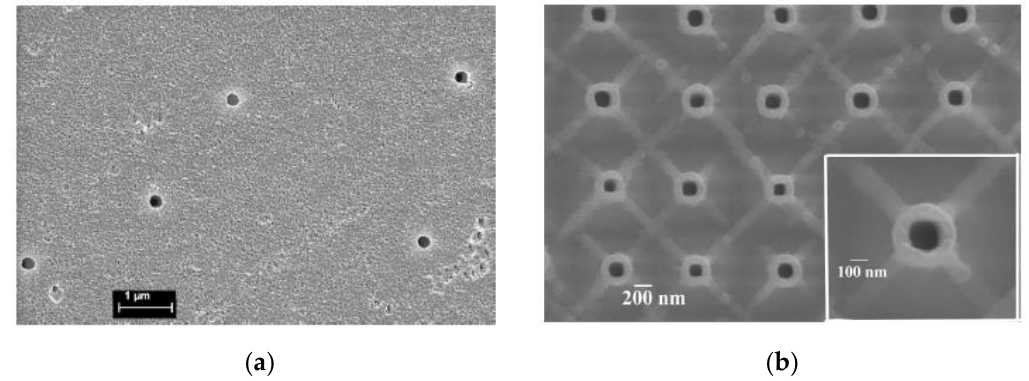
Figure 1. Examples of various capillaries in insulator foils: ( a ) a polyethylene terephthalate (PET) foil with capillaries whose diameter was 200 nm and density was 4 × 10 6 cm − 2 (reprinted figure with permission from [8] Copyright 2007 by the American Physical Society) and ( b ) well-aligned capillaries in a SiO 2 membrane with a thickness of 25 µ m [9]. The 100 nm diameter capillaries were 1.4 µ m apart from each other (from [9], Copyright 2011, with permission from Elsevier).